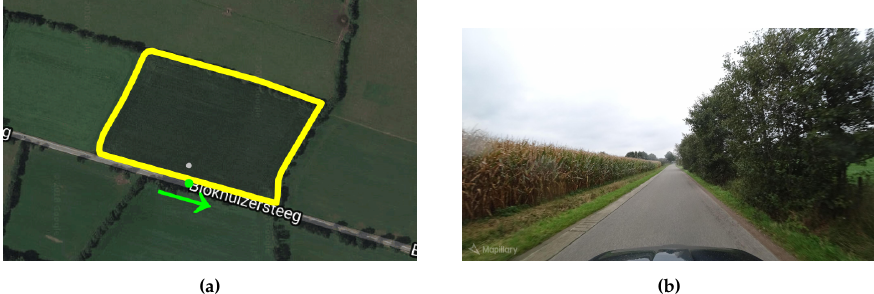
Figure 3. The photo-interpreters are given a high-resolution aerial image with the parcel and the point where the image was taken (a) along with the image to photo-interpret (b). This example shows a maize parcel on the left side of the road which is not yet